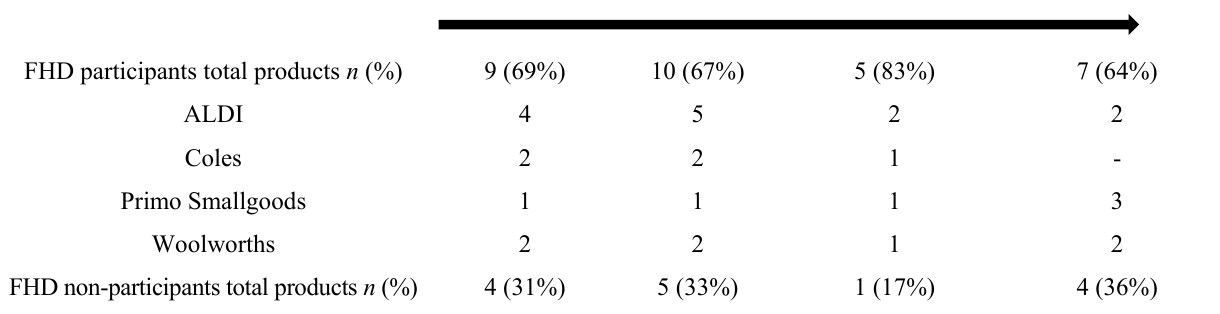
FHD target: maximum sodium 830 mg/100 g. Set in January, 2011, dead- line to meet due by December,